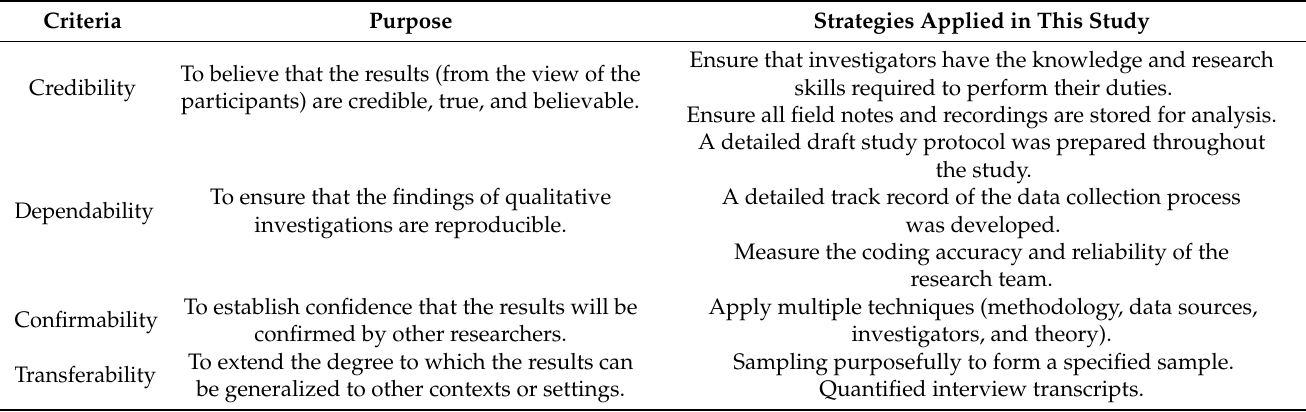
Table 1. Strategies adapted from Lincoln and Guba applied in this